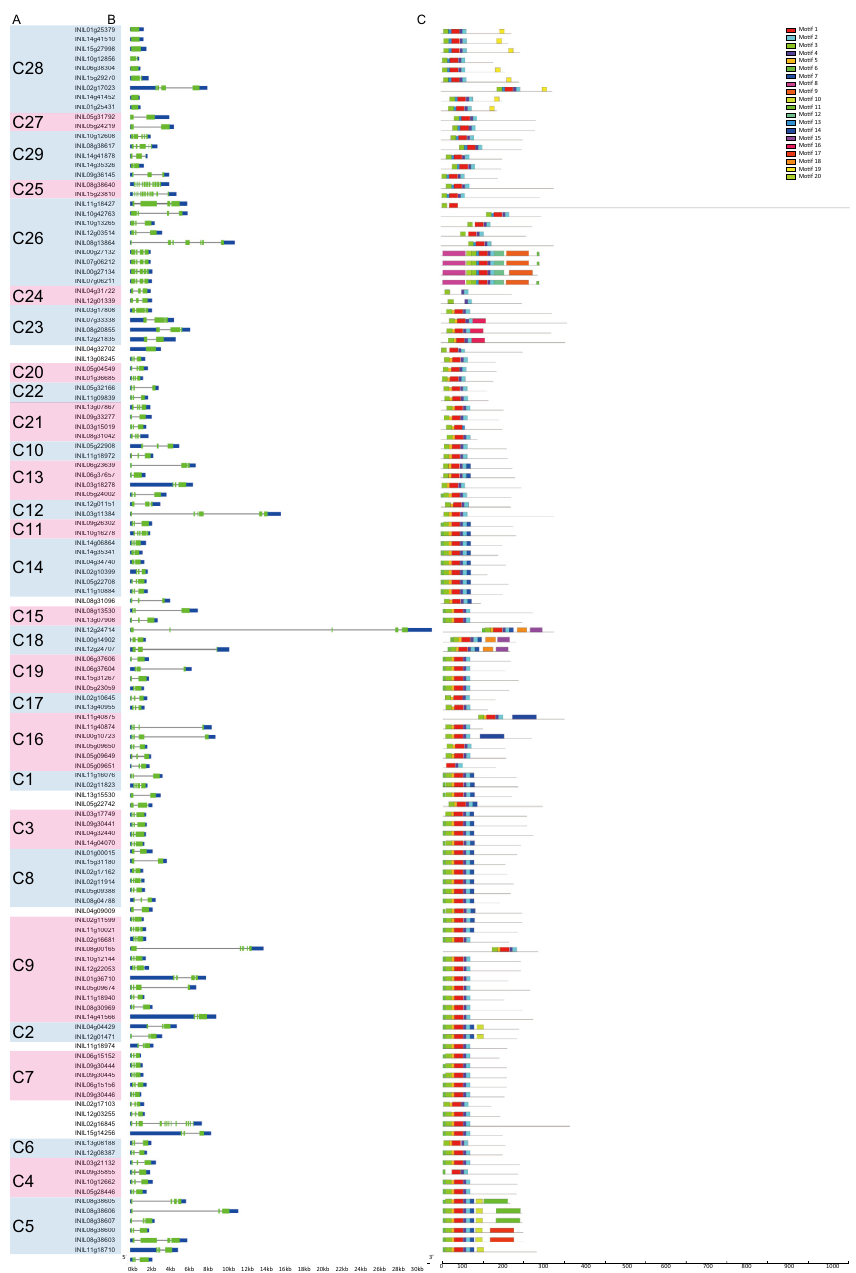
Fig 2. Gene structures and conserved protein motifs of the Japanese morning glory R2R3-MYBs. A: The list of R2R3-MYBs of the Japanese morning glory. The 127 R2R3-MYBs were clustered into 29 subfamilies. Numbers in parentheses indicates subfamily names of Arabidopsis R2R3-MYBs [9]. B: Exon-intron structures of the R2R3-MYBs . Exons are shown as green boxes, introns as black lines, and untranslated regions as blue boxes. C: Conversed protein motifs of the Japanese morning glory R2R3-MYBs. Motifs were identified using the MEME web server (https://meme- suite.org/meme/tools/meme). Different motifs are represented by different colored boxes. Details of the motifs were described in S3